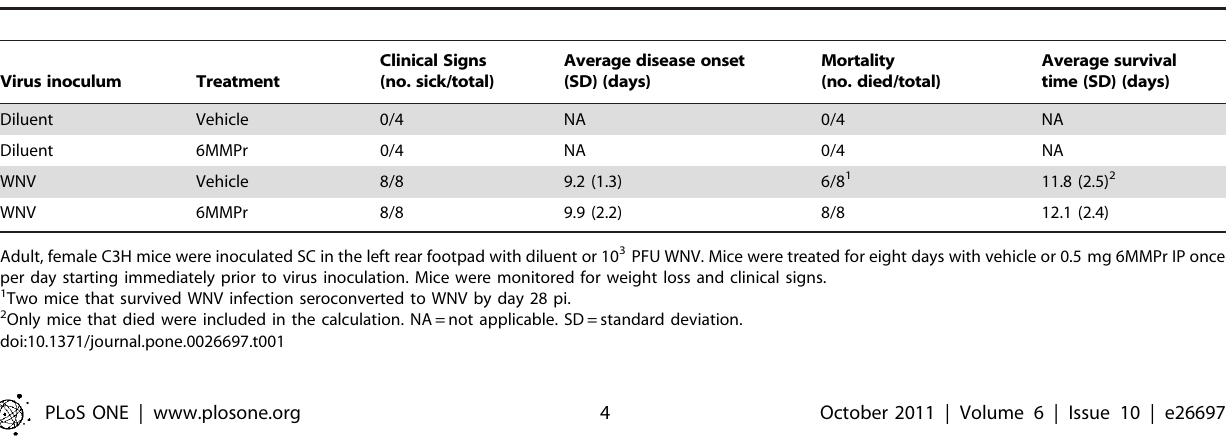
Table 1. Treatment with 6MMPr did not affect morbidity or mortality in WNV-inoculated mice.